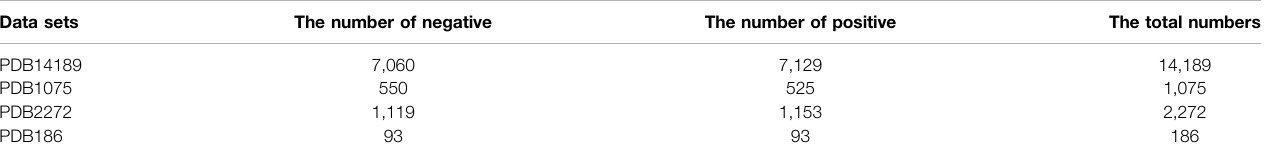
TABLE 2 | Basic information about four standard data sets.